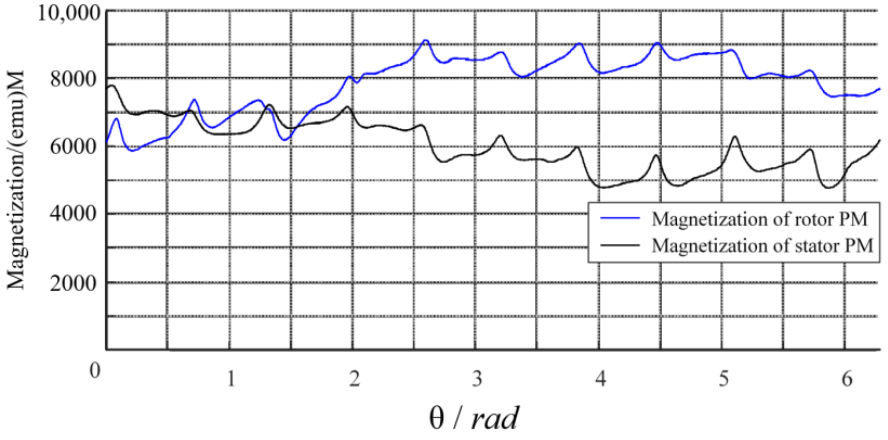
Figure 4. Axial magnetization of the PM in the PMB. Through the FFT transformation, the magnetization magnitude of the harmonic of the stator and rotor magnets is obtained (Figure